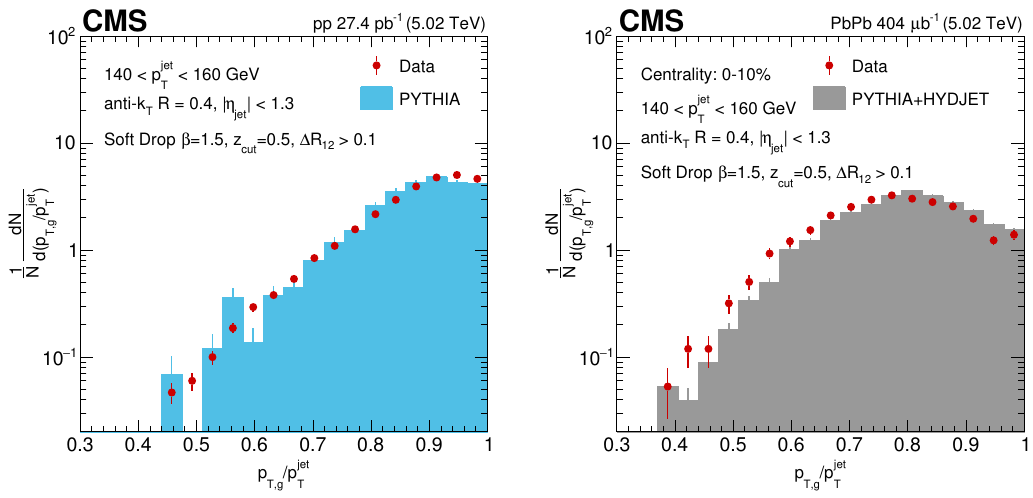
Figure 1 . Groomed jet momentum fraction p T ; g in pp (left) and the 10% most central PbPb collisions (right) for jets with 140 < p jet < 160 GeV and j (cid:17) jet j < 1 : 3. The pp data are compared to T simulation using the pythia event generator and the PbPb data are compared to the same pythia events embedded in PbPb events simulated with the hydjet event generator. Vertical lines indicate size of statistical uncertainty. The parameters used for the SD algorithm are z cut = 0 : 5, (cid:12) = 1 : 5. The jets are selected based on the ungroomed jet transverse